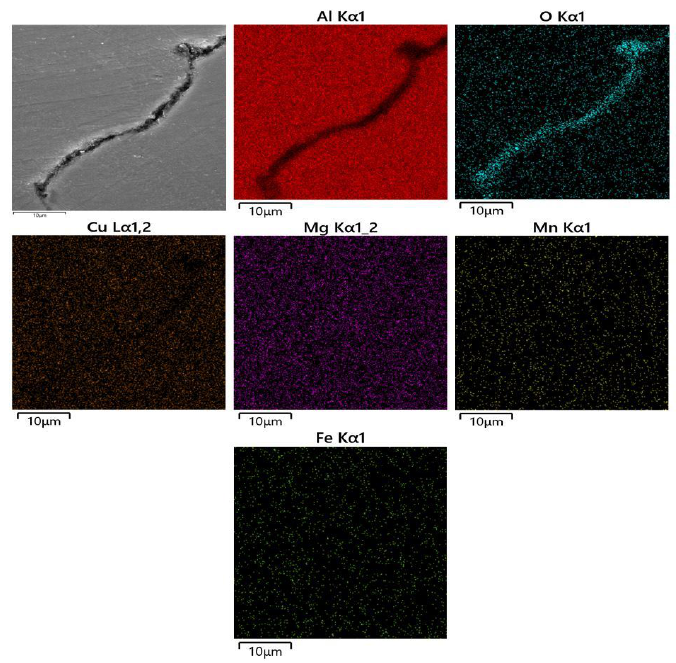
Figure 11. Energy disperse spectroscopy (EDS) mapping analysis results for a crack of Al-rich oxide clusters.